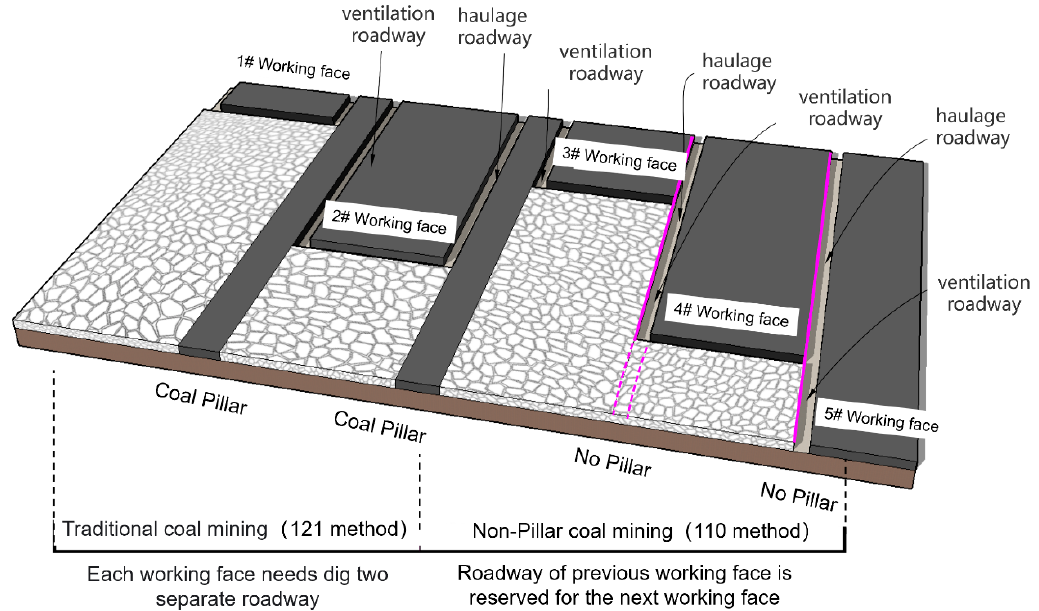
Figure 1. Schematic diagram of traditional coal mining (121-method, left half of the figure) and non-pillar mining with Gob-side Entry Retaining by Roof Cutting (GERRC) (110-method, right half of the figure).